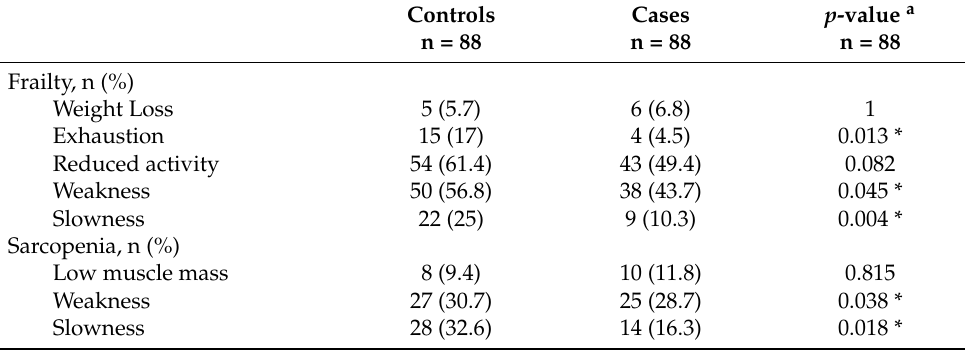
Figure 2. Results for frailty (panel A ) and sarcopenia (panel B ): Y-axis = percentage of subjects within group; X-axis = categories; blue columns = controls; red columns = cases; p = statistical significance. Table 3. Frailty and sarcopenia